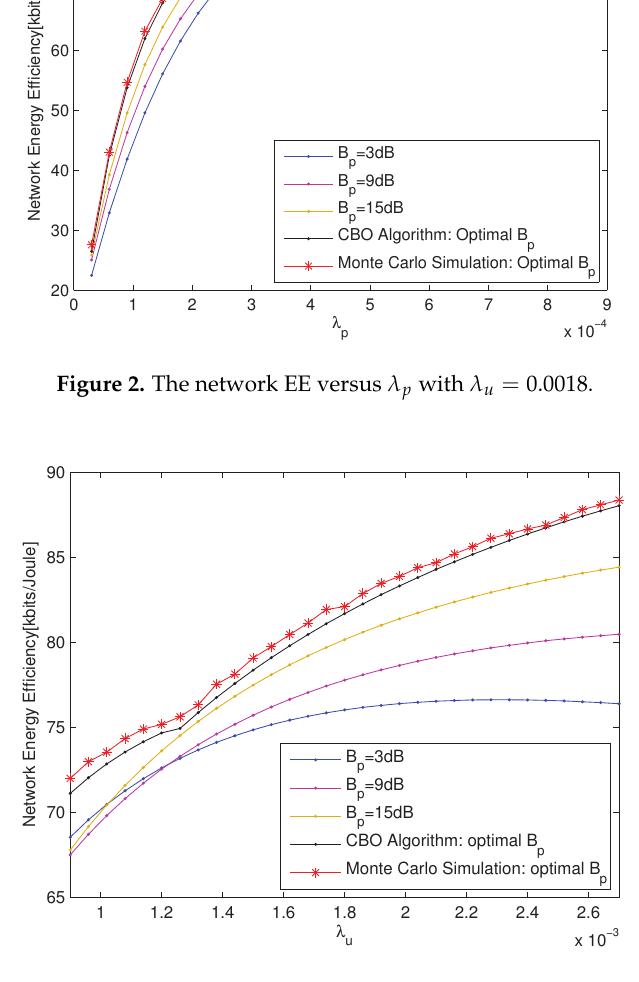
Figure 3. The network EE versus λ u with λ p =